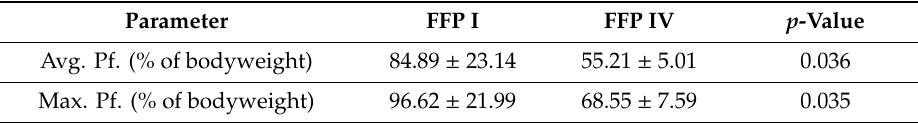
Table 6. FFP I vs. FFP IV.